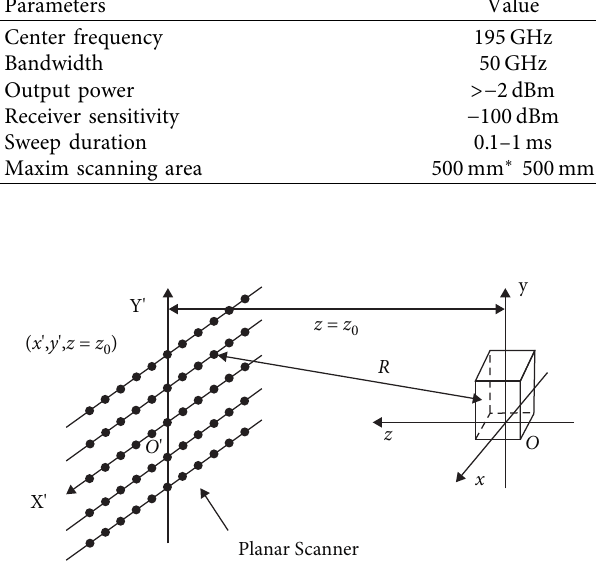
Figure 3: Imaging geometry of the developed THz FMCW imaging radar system.